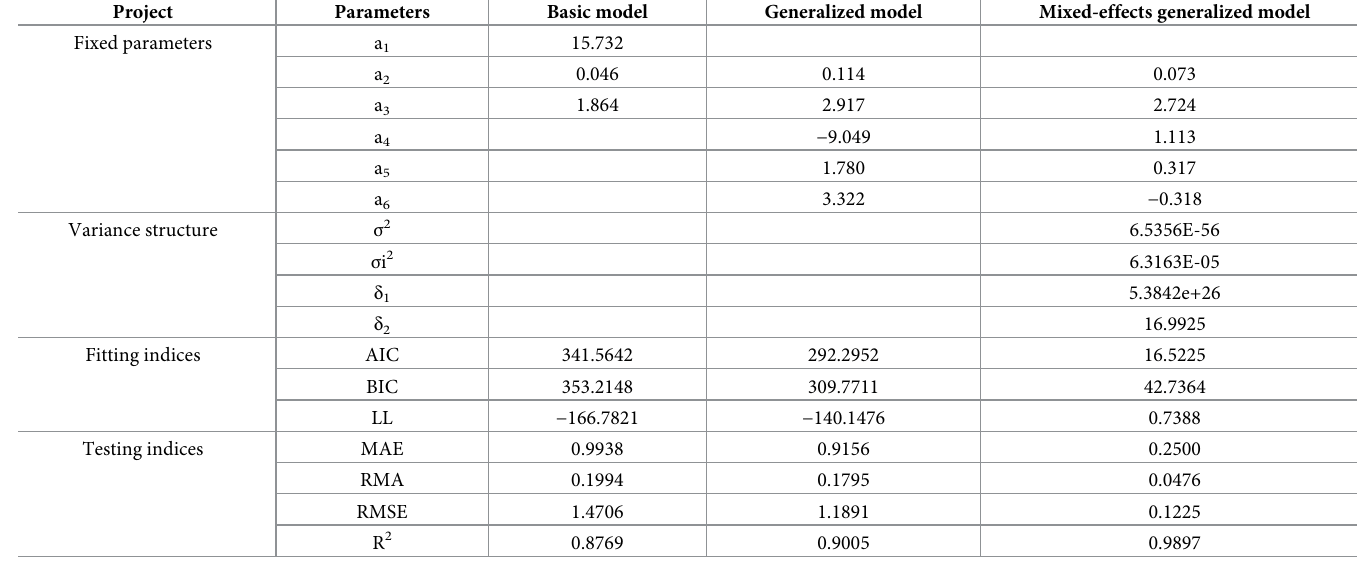
Table 4. Parameter estimates and variance structure of the three models and the associated fitting and validation statistical criteria.